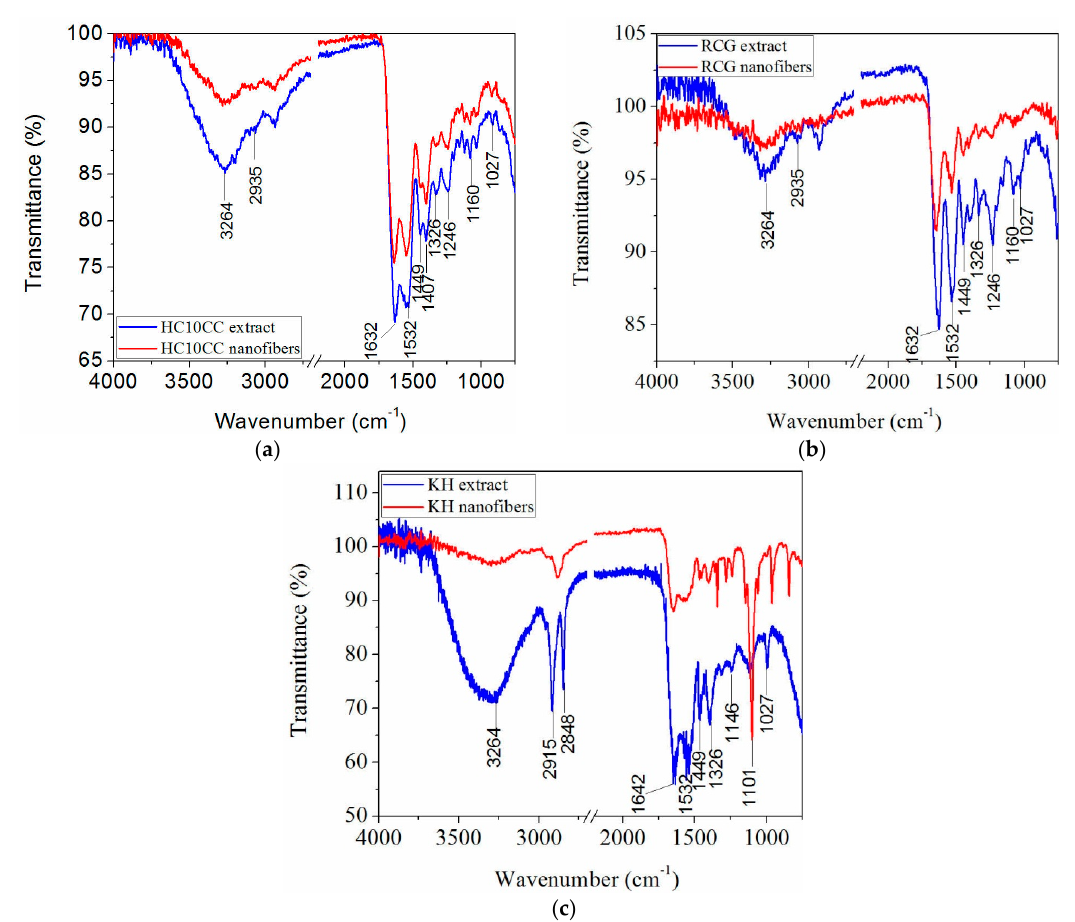
Figure 3. Comparative attenuated total reflectance Fourier transform infrared spectroscopy (ATR-FTIR) spectra of ( a ) HC10CC extract film and electrospun HC10CC nanofibers, ( b ) RCG extract film and electrospun RCG nanofibers, ( c ) KH extract film and electrospun KH nanofibers. The wavenumber region of interest is 4000 to 750 cm − 1 .